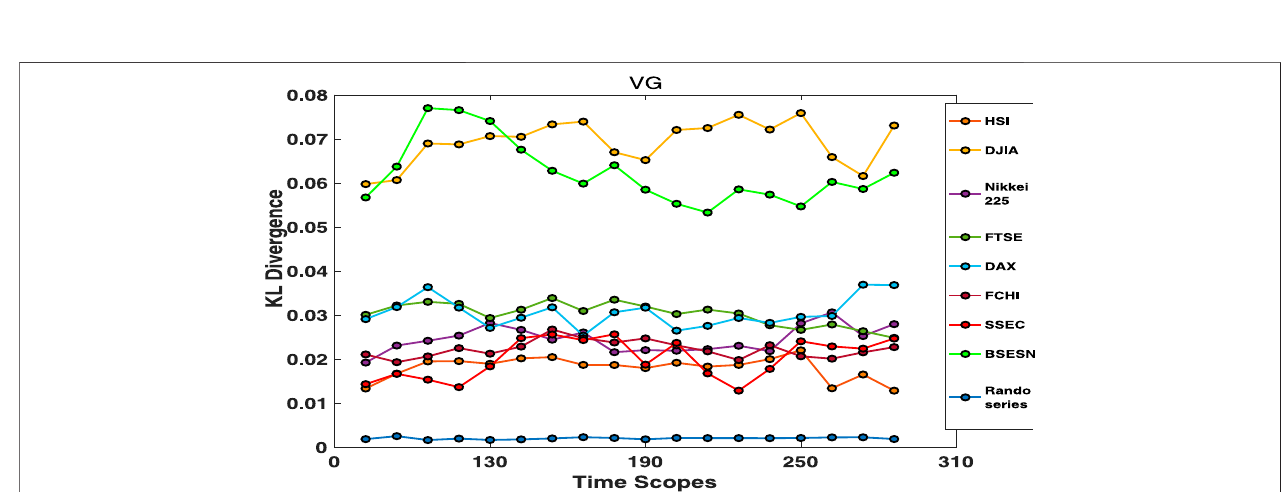
FIGURE 8 | KL divergence between I CC rise and fall distributions as functions of time scopes for eight stock indices and a random series.